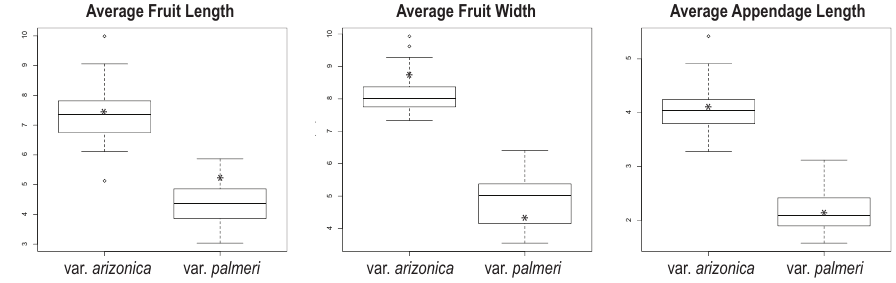
Figure 4. Box and whisker plots by taxon of A average maximum fruit length (mm), B average maxi- mum fruit width (mm), C average maximum subterete appendage length (mm). Asterisks denote the measured values of type specimens. Note significant differentiation in all features